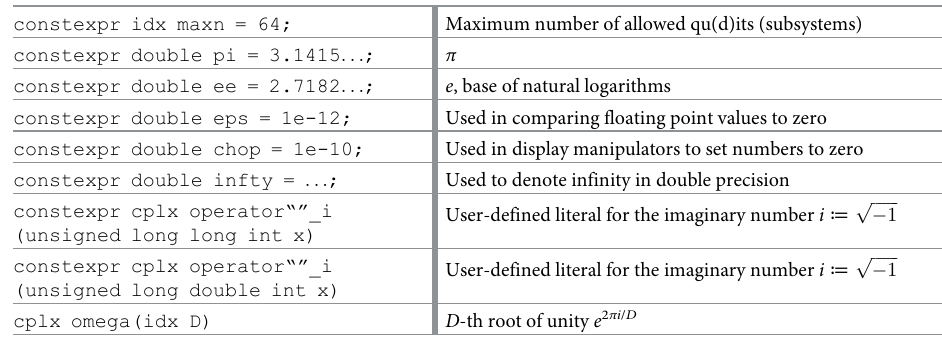
Table 2. User-defined